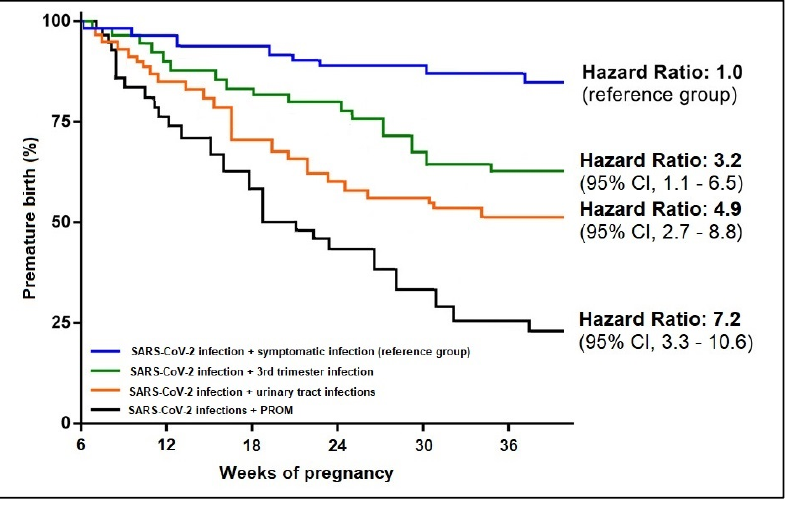
Figure 4. Kaplan-Meier probability analysis of premature birth by clinical predictors.